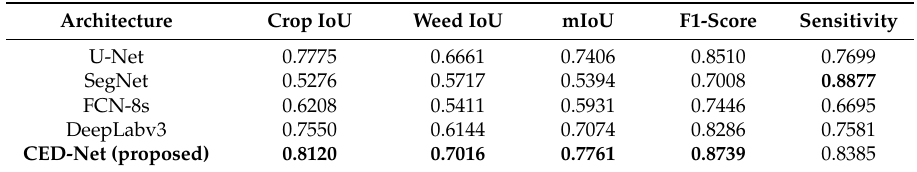
Table 7. Evolution of proposed architecture compared with other networks (bold number represents the best results in the table).